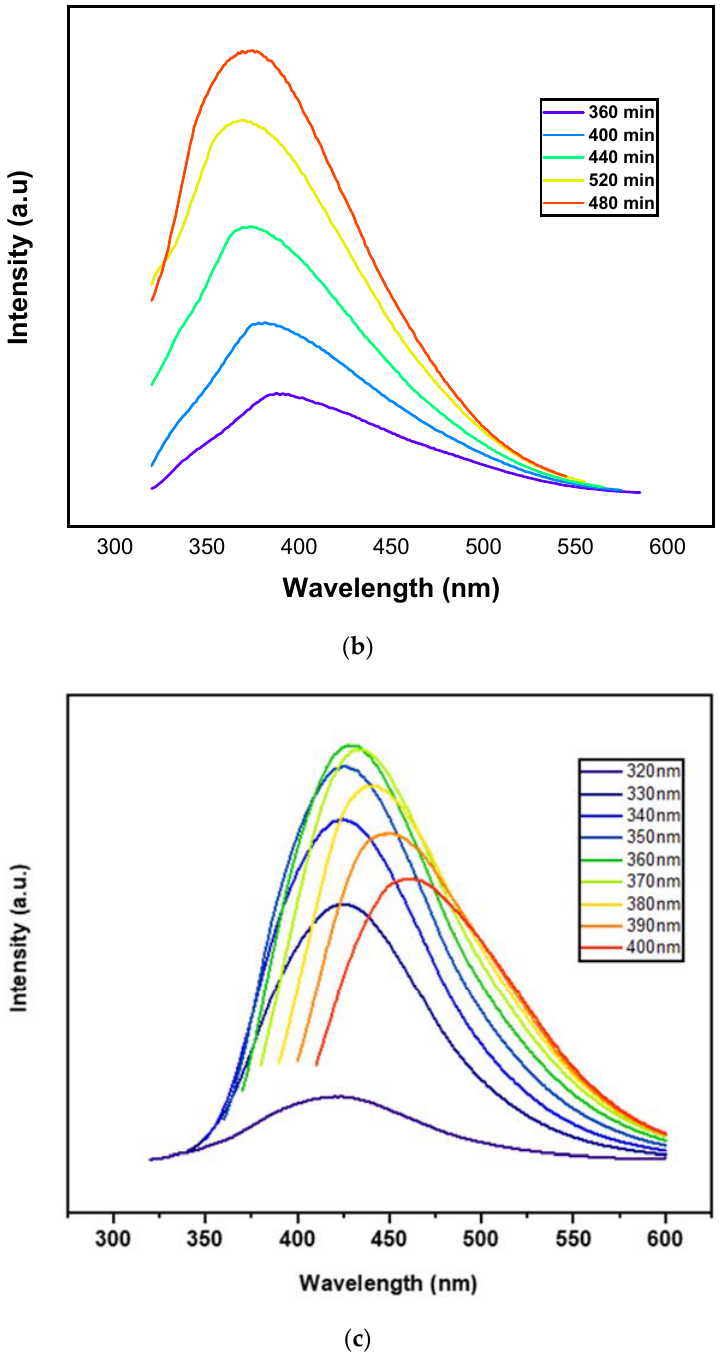
Figure 2. ( a ). PL of GQD at different temperatures (240, 260, 300, and 320 °C), ( b ). PL of GQD at different heat-treatment durations (360, 400, 440, 480, and 520 min) at a constant temperature of 300 °C ( c ) PL of GQD prepared at 300 °C after 480 min of treatment.